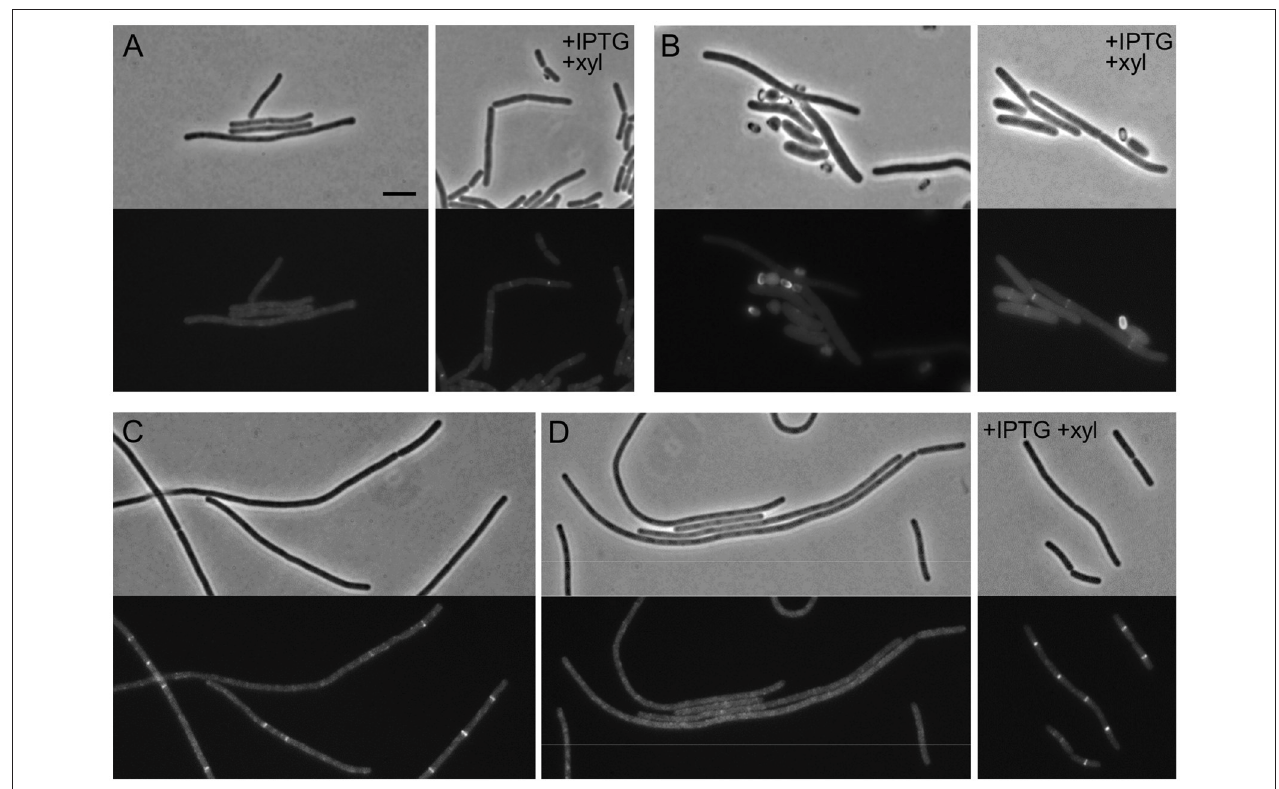
FIGURE 4 | The localization of FtsW, PBP 2B, and FtsL are interdependent. (A,B) Localization of FtsW in PBP 2B depleted cells and germinating spores. (A) Strain PG92 ( P spac -pbpB; P xyl -ftsL, ftsW-gfp ) was grown at 37 ◦ C in competence medium in the presence of 0.5% xylose and in the absence or in the presence of 1 mM IPTG. Phase contrast and GFP images were taken 5 h after depletion (8–9 generations). (B) Spores of strain PG92 were heat shocked and germinated as described in the presence of 0.5% xylose and in the absence or in the presence of 0.5% xylose. Phase contrast and GFP images were taken 4 h after the beginning of germination. (C,D) Localization of FtsW in FtsL depleted cells. Strain PG92 was grown in competence medium at 37 ◦ C in the presence of 1 mM IPTG and in the absence or in the presence of 0.5% xylose. Phase contrast and GFP images were taken after 4 h (C) or 5 h (D) of depletion. Scale bar indicates 5 µ